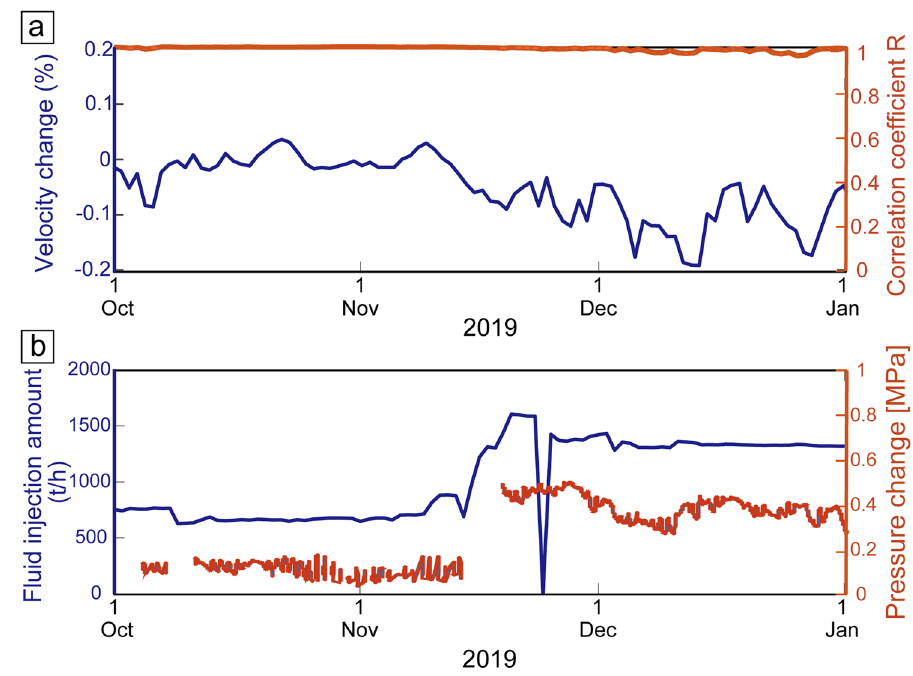
Figure 8. Monitoring results and geothermal operation data during 3 months. ( a ) Temporal velocity variation between the source system and a seismometer ~ 1.75 km (blue), and its correlation coefficient R between current and reference trances (orange). The velocity variation is derived from vertical source motion and vertical receiver component (blue). The geothermal fields locate between the source and the seismometer. ( b ) Temporal variations of fluid injection amount (blue) and pressure change in the reservoir